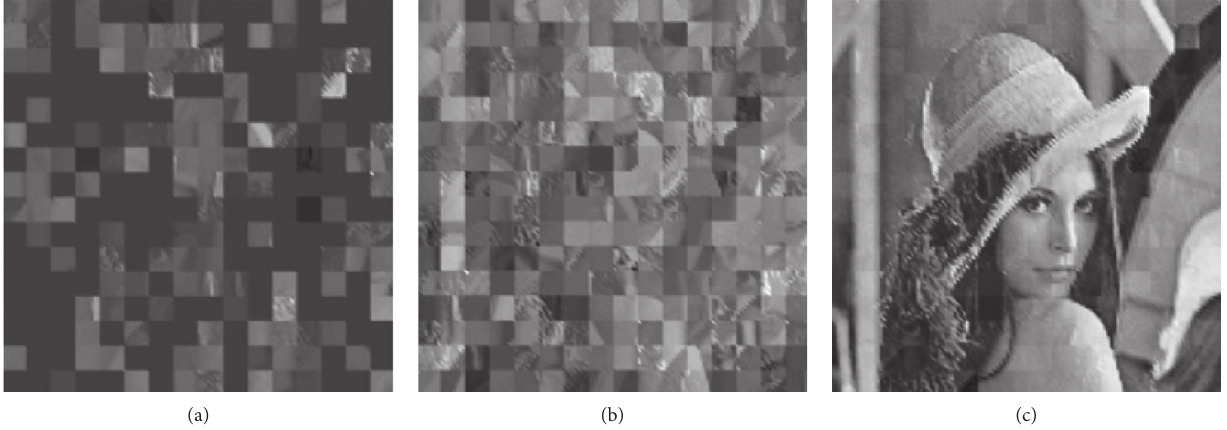
Figure 8: Reconstructed images with different measurements. The measurement and r (c) 2800, 0.9533.